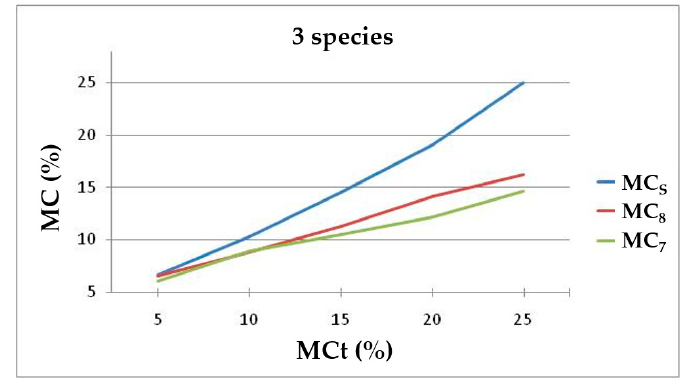
Figure 7. Trend lines of MCs, MC 8 and MC 7 (%) as a function of MCt for all three species together. A model for specimens’ MC estimation based on the mass of the wet and dry filters filled with